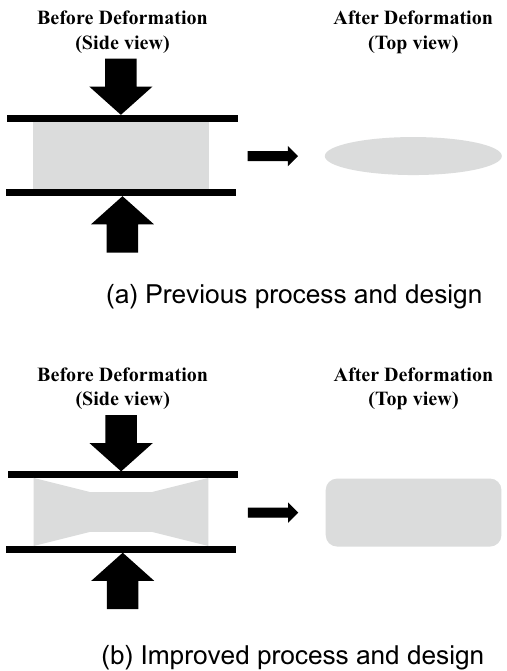
Figure 9. Improved design for hot plate rolling in the iron-making industry 26